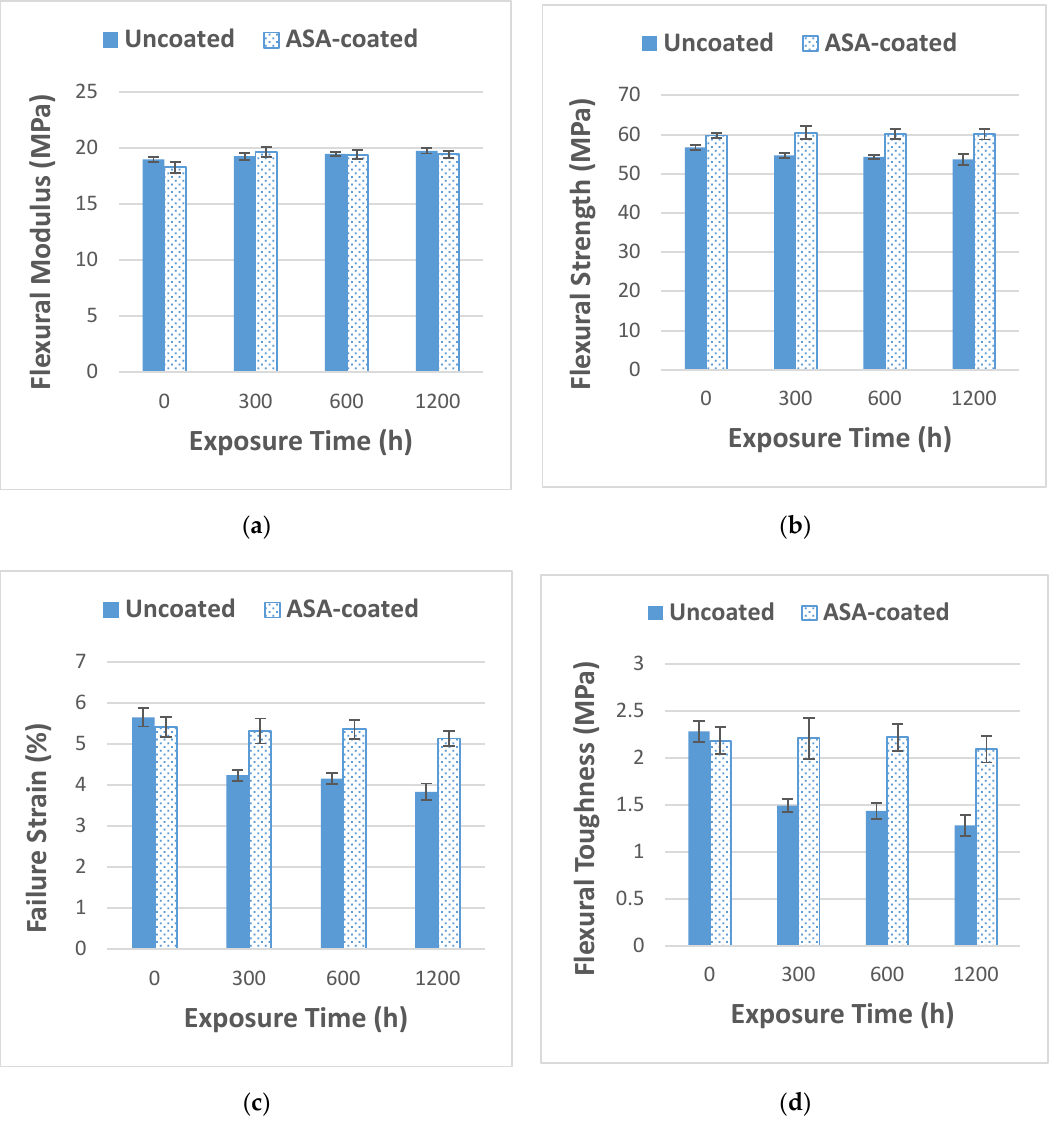
Figure 6. Flexural properties of uncoated and ASA-coated 3D printed ABS samples during exposure to UV radiation and moisture. ( a ) Flexural modulus; ( b ) flexural strength; ( c ) failure strain; ( d ) flexural toughness.